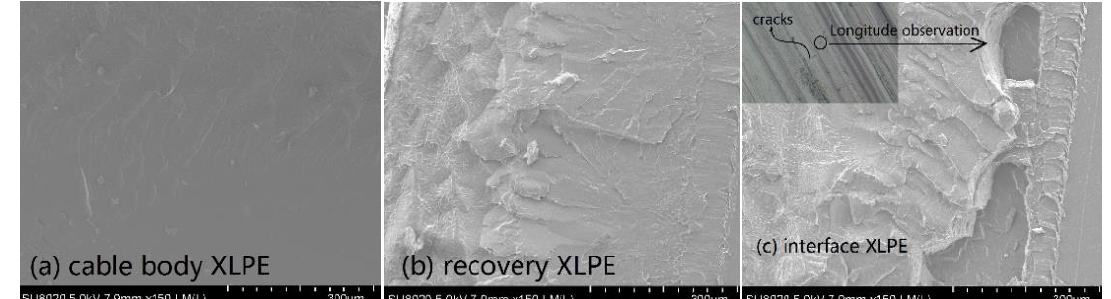
Figure 4. SEM images of fractured surfaces localized at ( a ) cable body, ( b ) recovery insulation, and ( c ) interface region in cross-linked polyethylene (XLPE) EMJ.